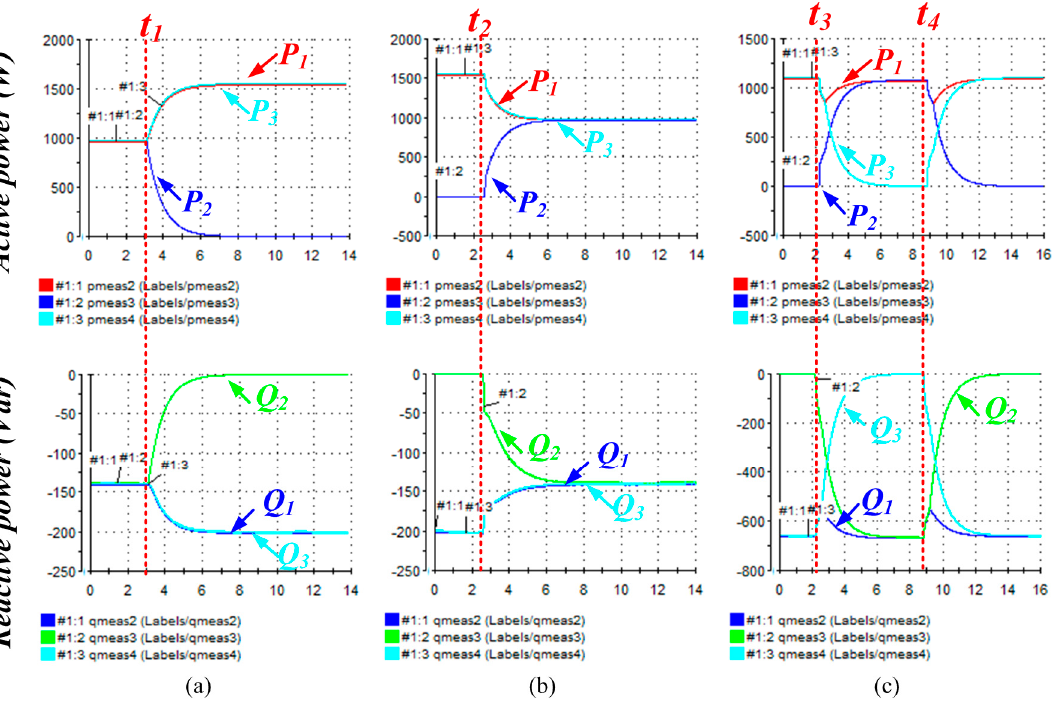
Figure 3. Power performance: ( a ) one module plug out; ( b ) module plug in; and ( c ) cycle control.